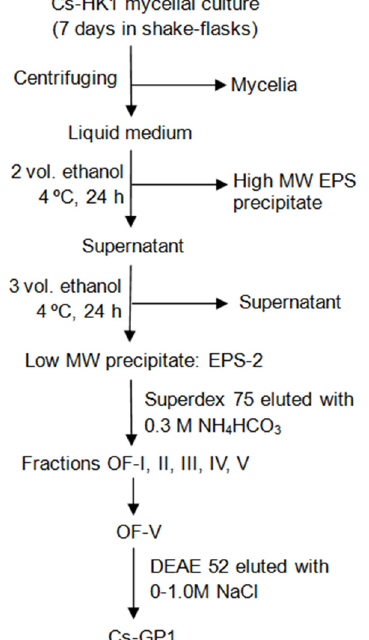
Figure 5. Procedure for isolation and fractionation of EPS from Cs-HK1 mycelium liquid medium and the purification of glycopeptide